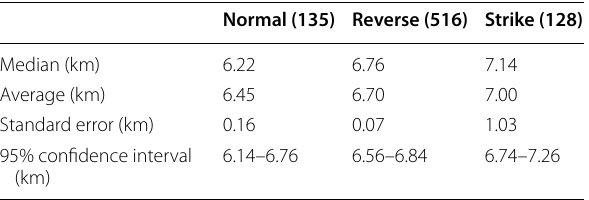
Table 1 Median and average values of hypocentral depths of each faulting